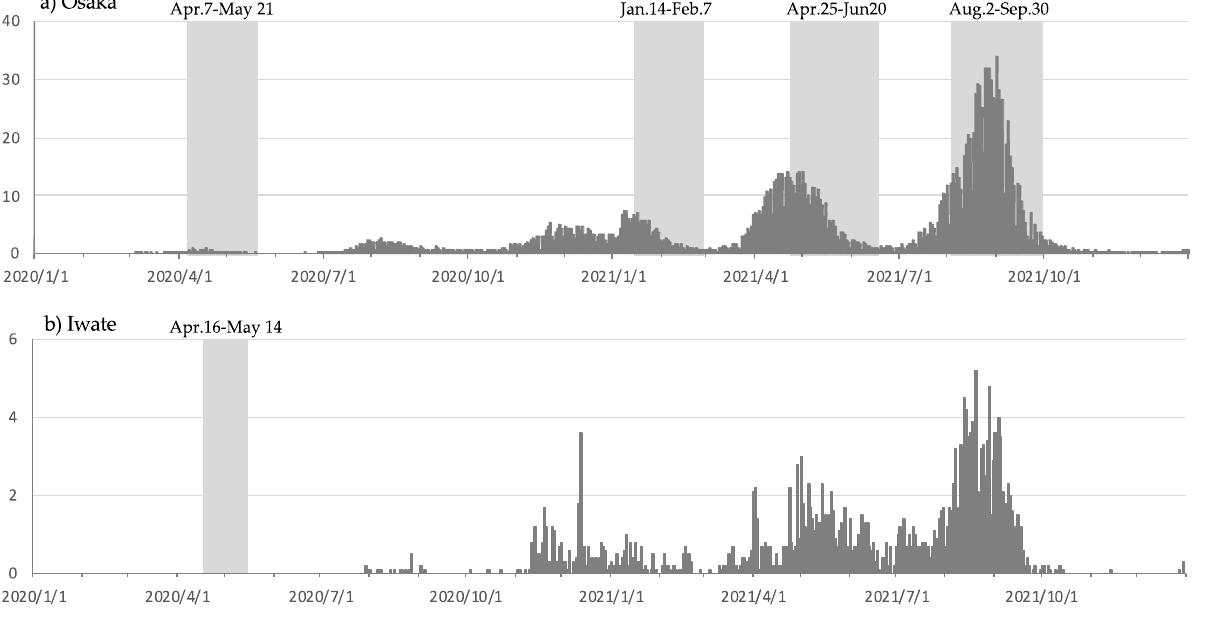
Figure 2. The daily reported number of confirmed cases of SARS coronavirus 2 in distinct regions in Japan from 16 January 2020 to 2021: ( a ) in Osaka, ( b ) in Iwate. These data were taken from the open resources of the Japan Broadcasting Corporation. The period of the declared state of emergency is indicated by gray shading and the date. Osaka is one of the endemic areas in Japan. There were no reports of confirmed COVID-19 cases until the end of July 2020 in Iwate.